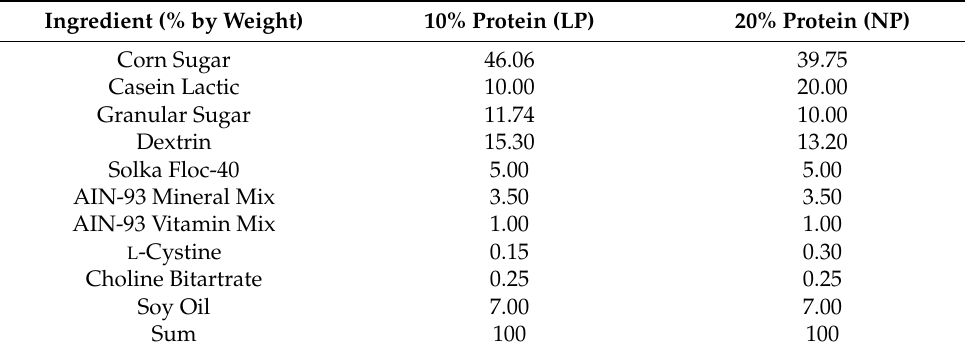
Table 1. Diet formulations with different protein